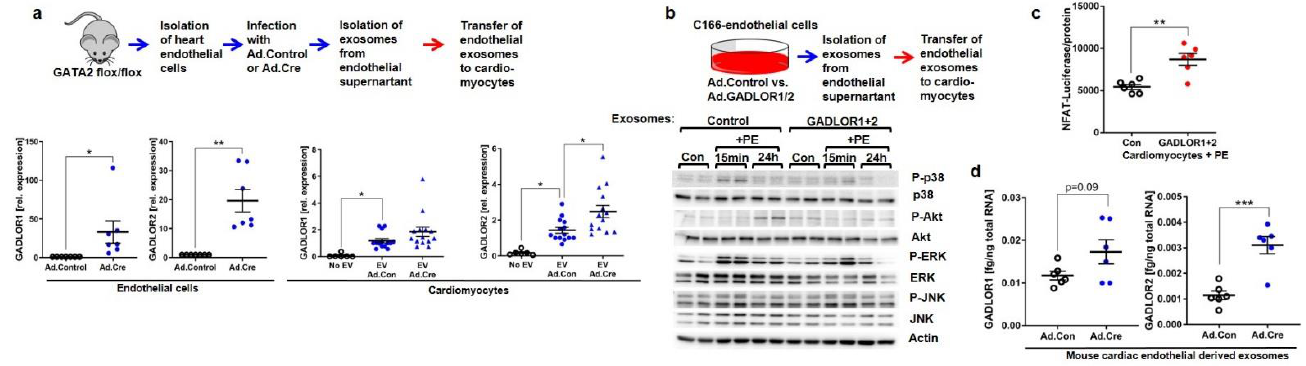
Figure 7. Regulation of cardiomyocyte signaling by endothelial GADLOR1 and 2. ( a ) Experimental scheme ( above ) and qPCR ( below ) of GADLOR1 and 2 in isolated GATA2flox/flox endothelial cells (ECs) treated with Ad.Cre or Ad.Control and in cardiomyocytes (CM) treated with exosomes from supernatants of these ECs. ( b ) Experimental scheme ( above ) and ( below ) immunoblots of indicated proteins from CMs treated as shown. ( c ) Luciferase activity from CMs infected with Ad.NFAT-Luc, treated with PE and exosomes. ( d ) qPCR of GADLOR1 and 2 in exosomes isolated from the supernatant of cardiac endothelial cells treated as shown. Data are mean ± sem; the number of biological replicates is shown in the graphs; * p < 0.05, ** p < 0.01, *** p < 0.001, **** p < 0.0001.